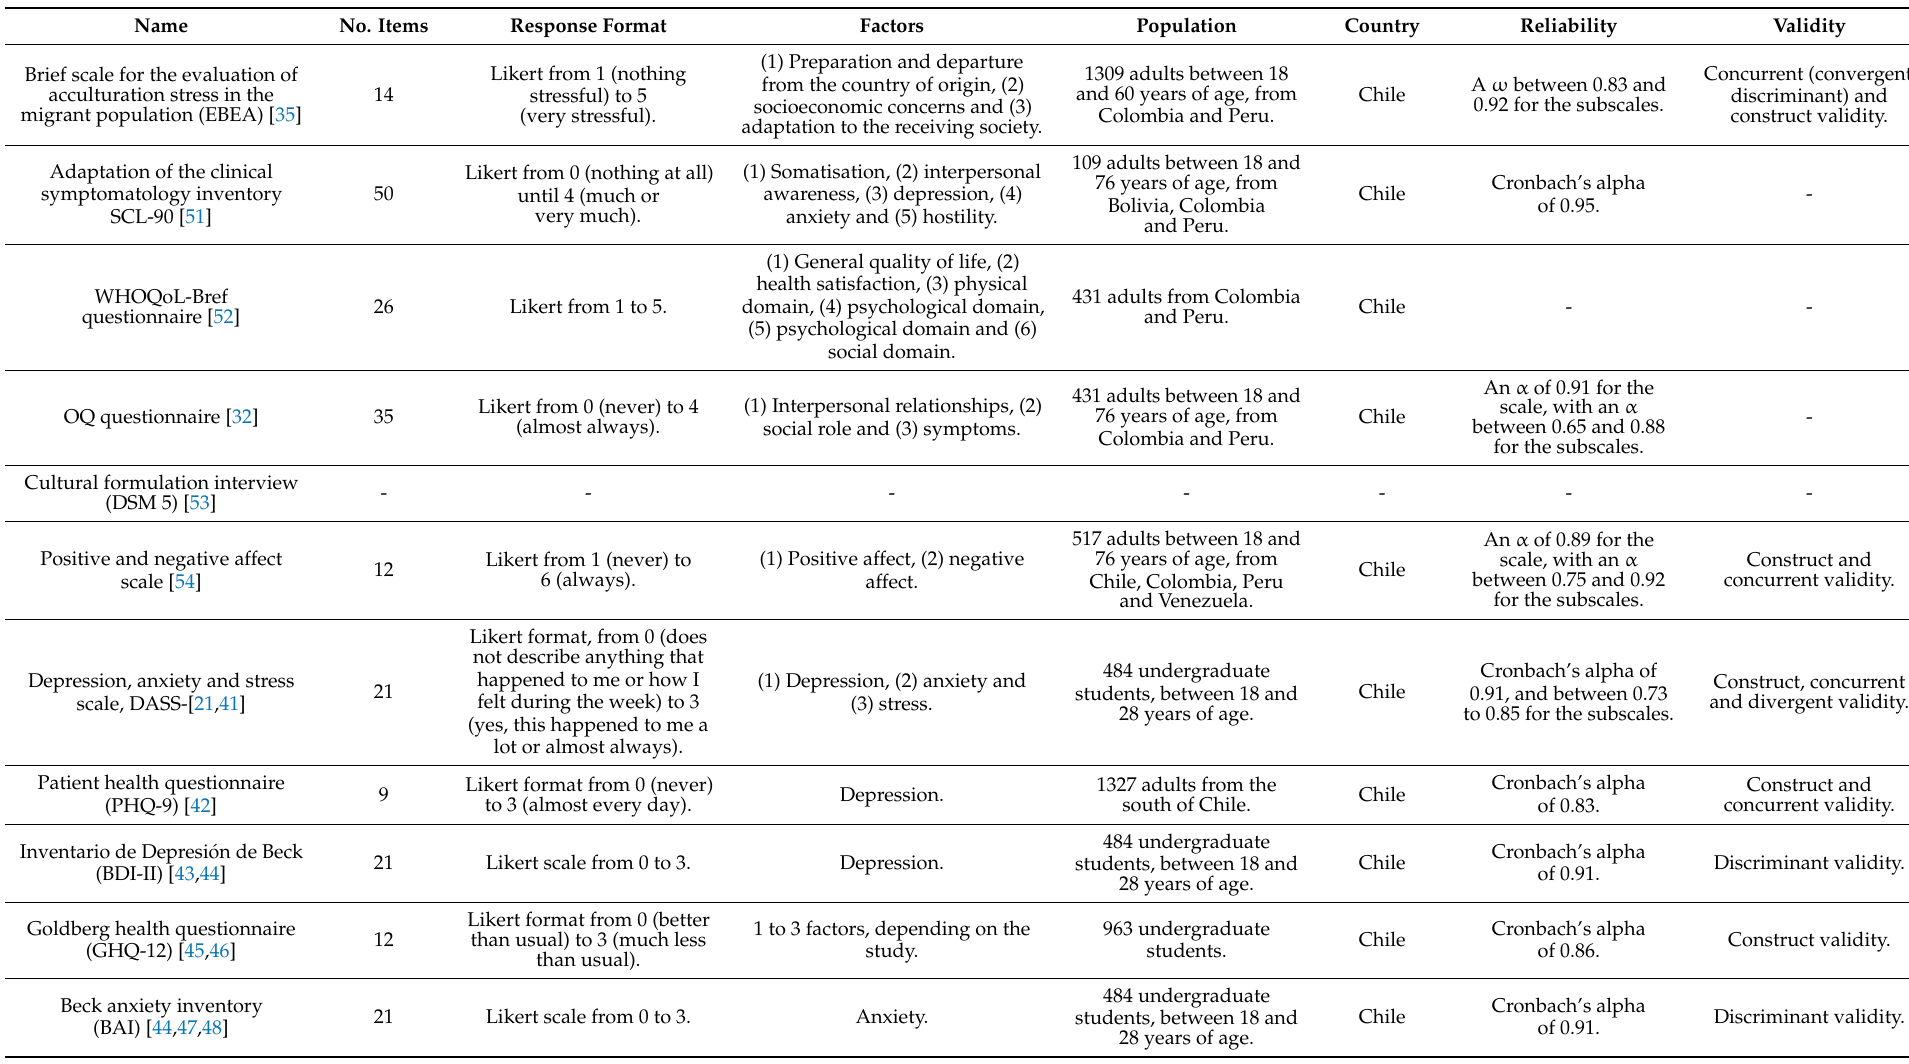
Table 1. Instruments to Assess the State of Mental and Physical Health in emerging adults and